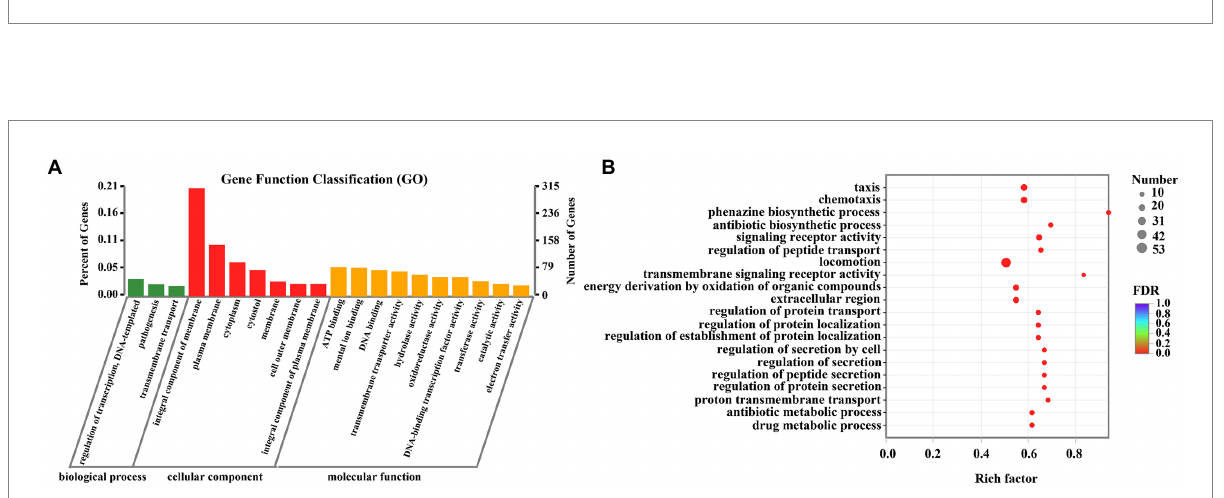
FIGURE 6 Heat map (A) and volcano plots (B) of DEGs in P. aeruginosa PAO1 after thymoquinone treatment. For heat map, each row represents the expression pattern of a single gene and each column corresponds to a single sample. The expression levels are represented by colored tags, with red representing the highest levels of expression and blue representing the lowest levels of expression. For volcano plots, the red dots represent up-regulated DEGs, the green dots represent down-regulated DEGs and the gray dots represent genes with no significant changes in